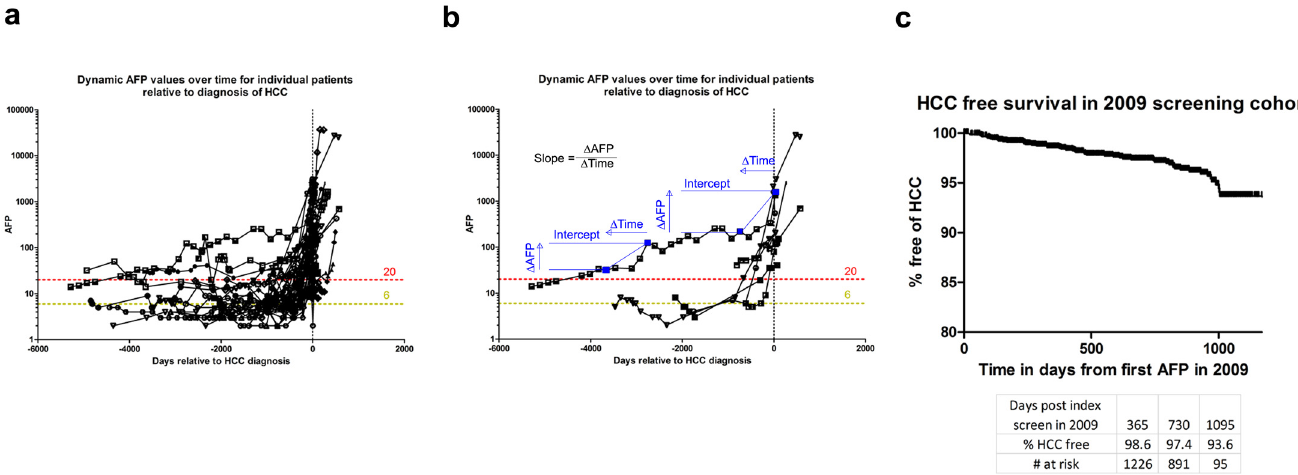
Fig 2. Dynamic AFP changes associated with HCC development. A ) Plotting each individual ’ s time course of serum AFP relative to diagnosis an elevation in values is observed prior to diagnosis. Here all individuals in the HCC review in whom AFP influenced clinical management (n = 49) are charted with AFP on a log 10 scale. B ) Graphic demonstrates the concept of gradient and intercept over a specific individual ’ s time course. C ) The screening cohort of 1509 patients followed over time for development of HCC, overall incidence at end of index screening (1186 days from 01/01/2009, total HCC free % =